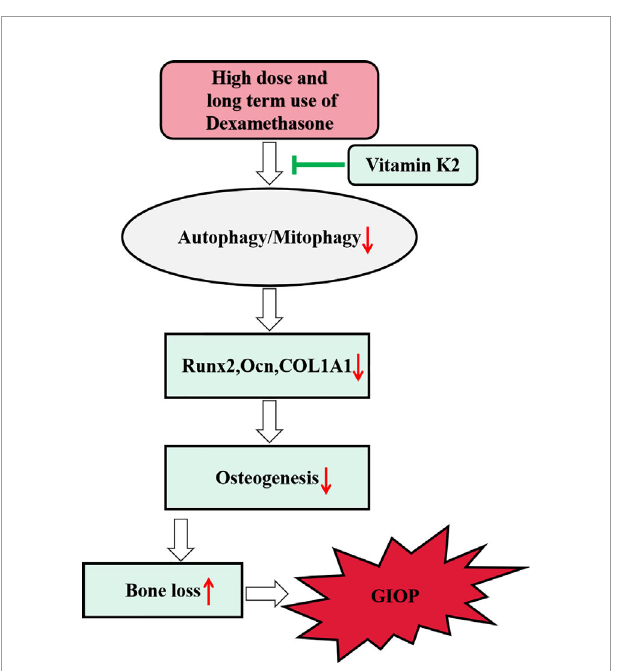
FIGURE 7 | Schematic diagram of proposed mechanism underlying the role of autophagy/mitophagy in mediating the bene fi cial effect of VK2 against Dexamethasone-induced